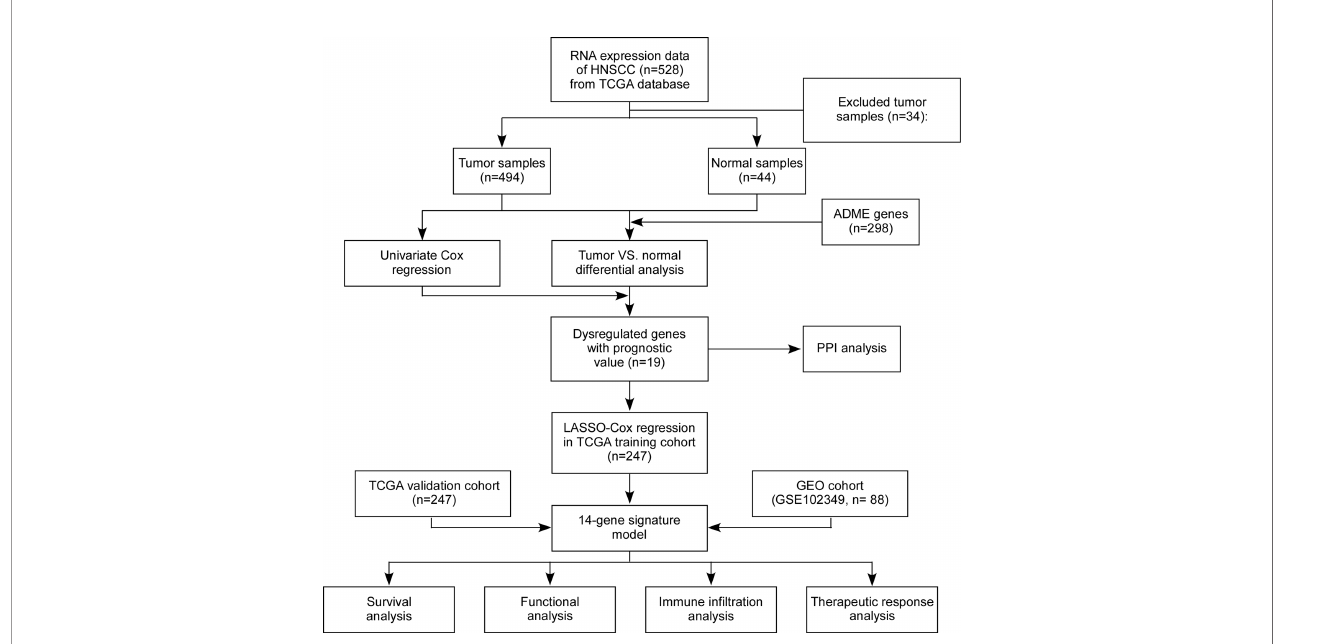
FIGURE 1 | Flow chart of data collection, analysis and